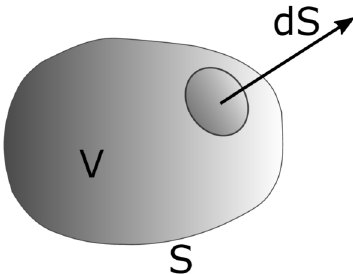
Figure 3. Volume V is limited with the boundary S that is directed toward the